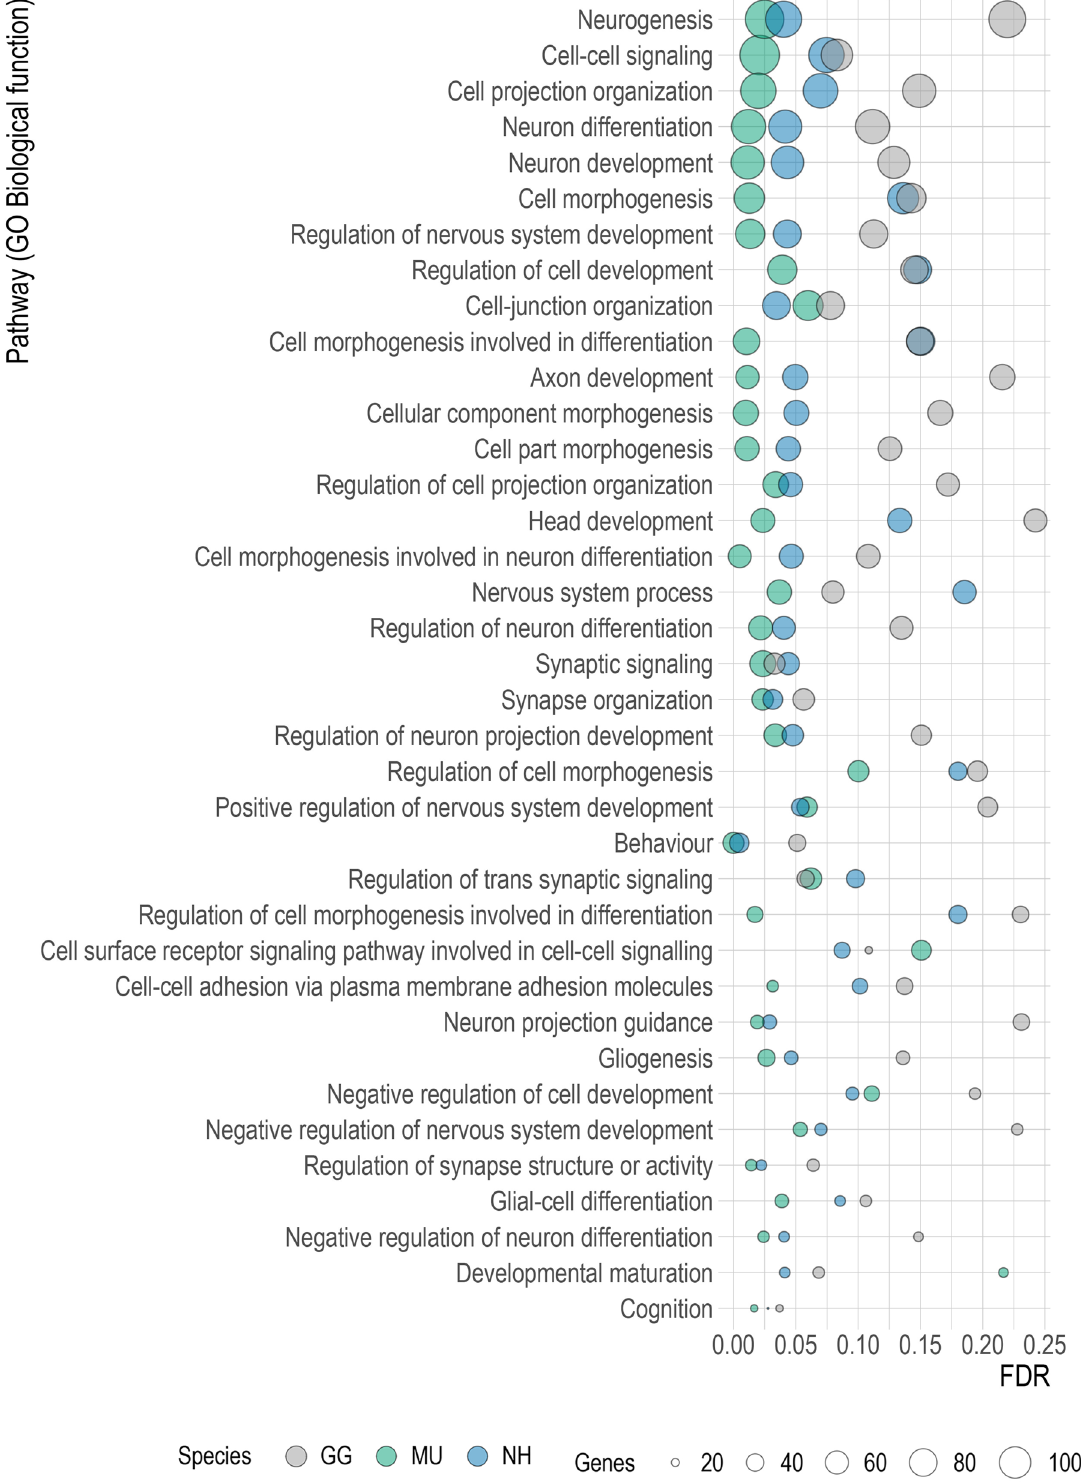
Figure 7. Significant gene sets related to neural function commonly enriched in all species. The dot plot shows the identified enriched terms by GSEA with nominal p value < 0.05. P values were adjusted for multiplicity of testing. The x-axis shows the range of the false discovery rate (FDR) values, the y-axis lists the GO Biological function terms, the colours indicate the involved species and the dot size shows the number of genes in each set (GSEA version 4.1.0, http://www.gsea-msigd b.org; R version 4.0.0, www.r-proje